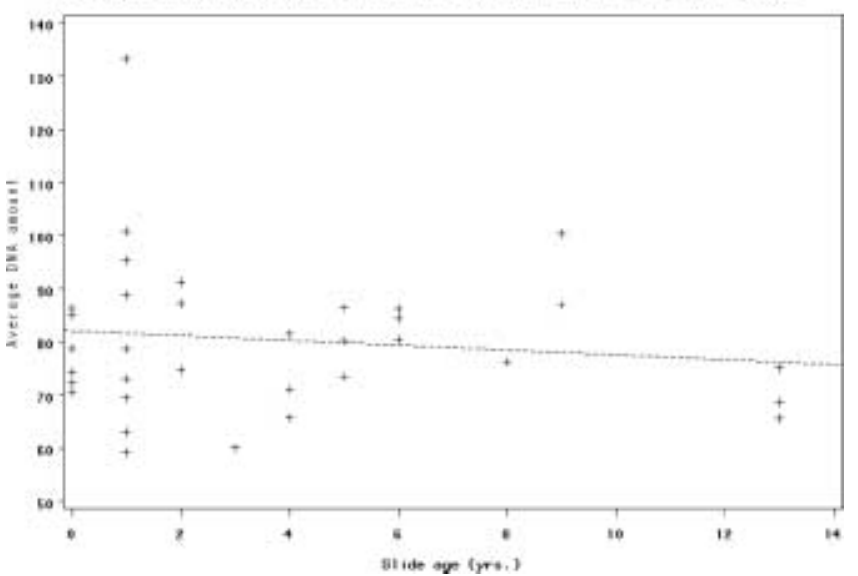
Fig. 2. This figure shows the plot of the average normal DNA amount for each of the tissue slices plotted against the age of the slide. The dotted line is the regression line. The slope of the regression line was not statistically